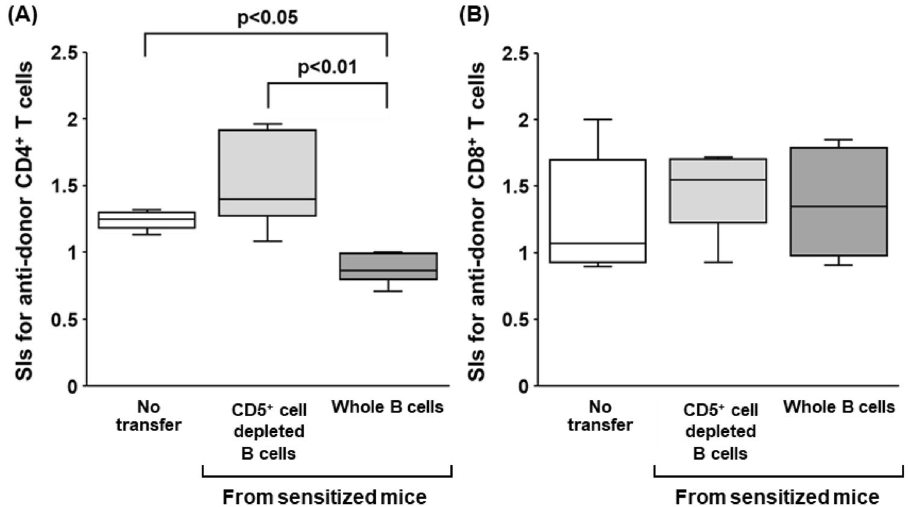
Figure 7. Effect of various B cell subsets from sensitized mice on anti-donor T-cell responses. To further investigate the inhibitory effects of B cells, either whole B cells or CD5 + B cell-depleted B cells from sensitized mice were co-cultured in CFSE-MLR assays of the desensitization group. The SI values of each of the anti-donor CD4 + T cell ( A ) and CD8 + T cell ( B ) subsets in MLR are shown. Data from five independent experiments